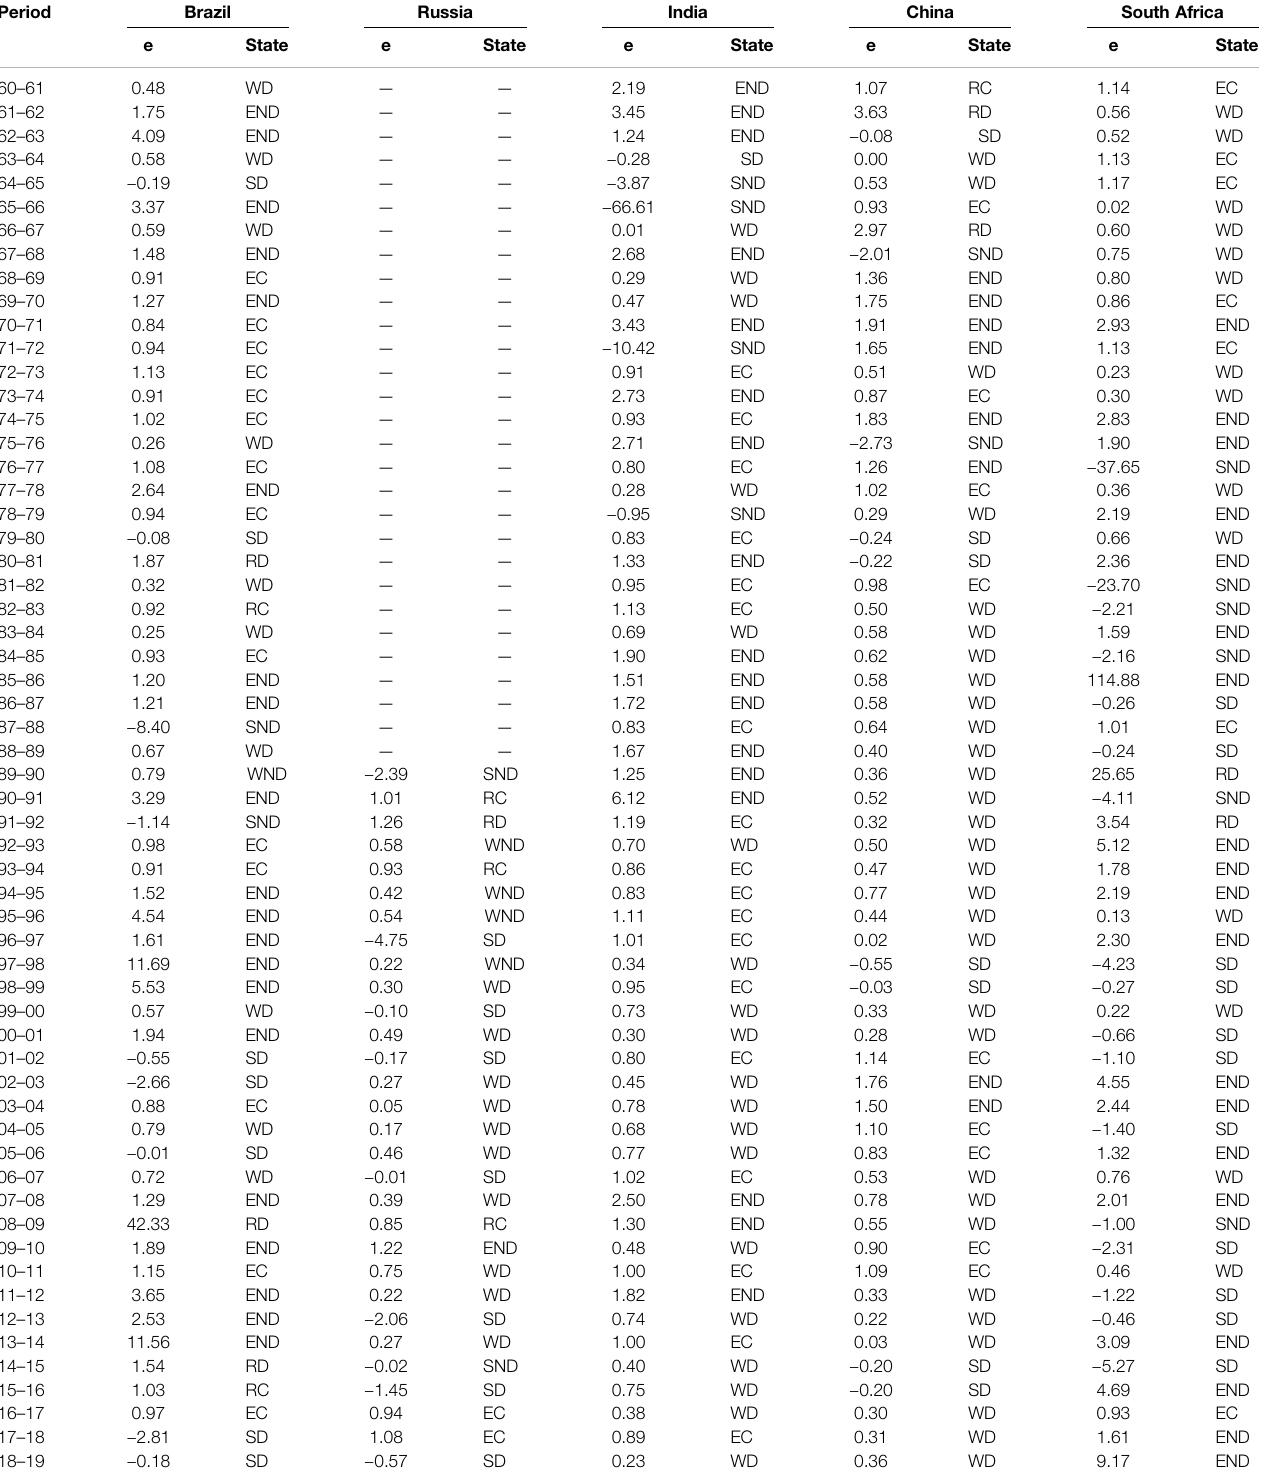
TABLE 3 | Decoupling states of carbon emission and economic growth.